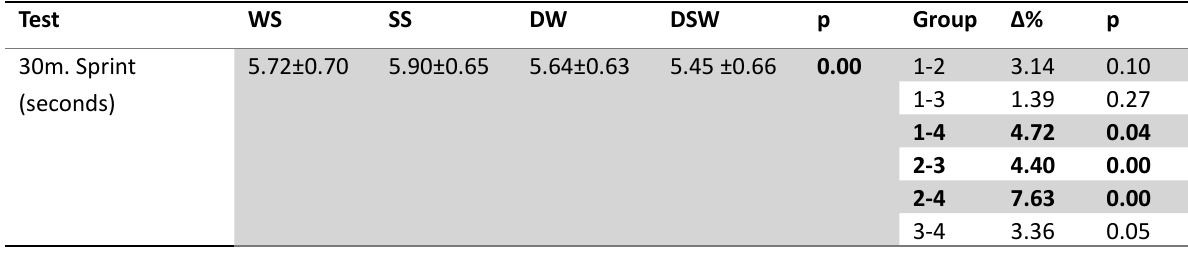
Table 1. 30 m. sprint values and differences after different stretching and warm up protocols Test 30m. Sprint